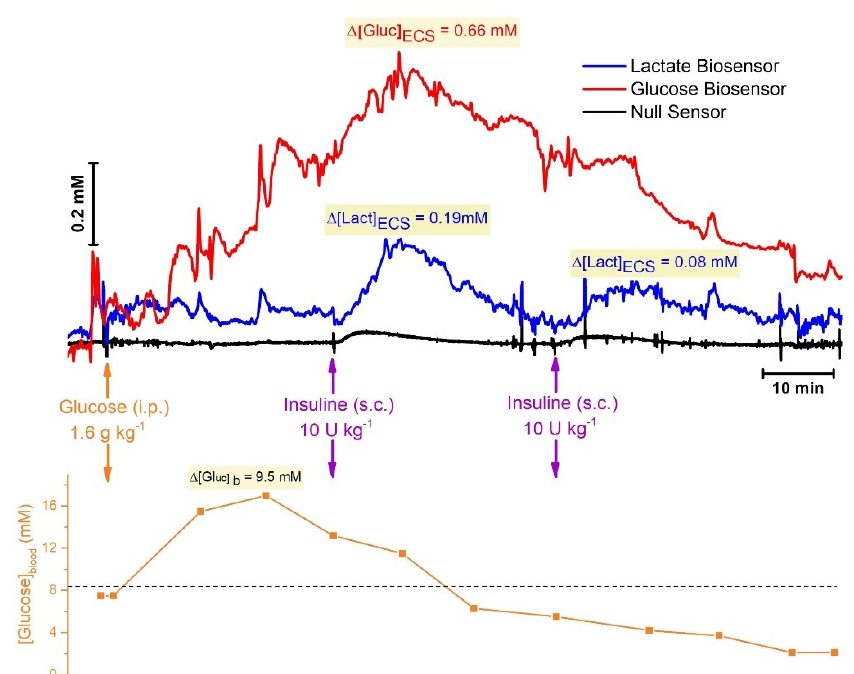
Figure 6. Top Panel: In vivo monitoring of lactate (blue) and glucose (red) in the brain extracellular space (hippocampus, AP: − 3.5; ML: − 2.5; DV: − 2.9). Black line represents current recorded at the null sensor. Bottom Panel: Systemic glucose concentration measured in 10 min intervals using a commercial glucose meter and blood collected from tail vain. Dotted line represents basal blood glucose concentration. Arrows indicate moment of system administration of glucose (1.6 g kg − 1 , intraperitoneal) and insulin (10 U kg − 1 , sub-cutaneous). Shade boxes highlight maximal variation in the concentration of each analyte measured.